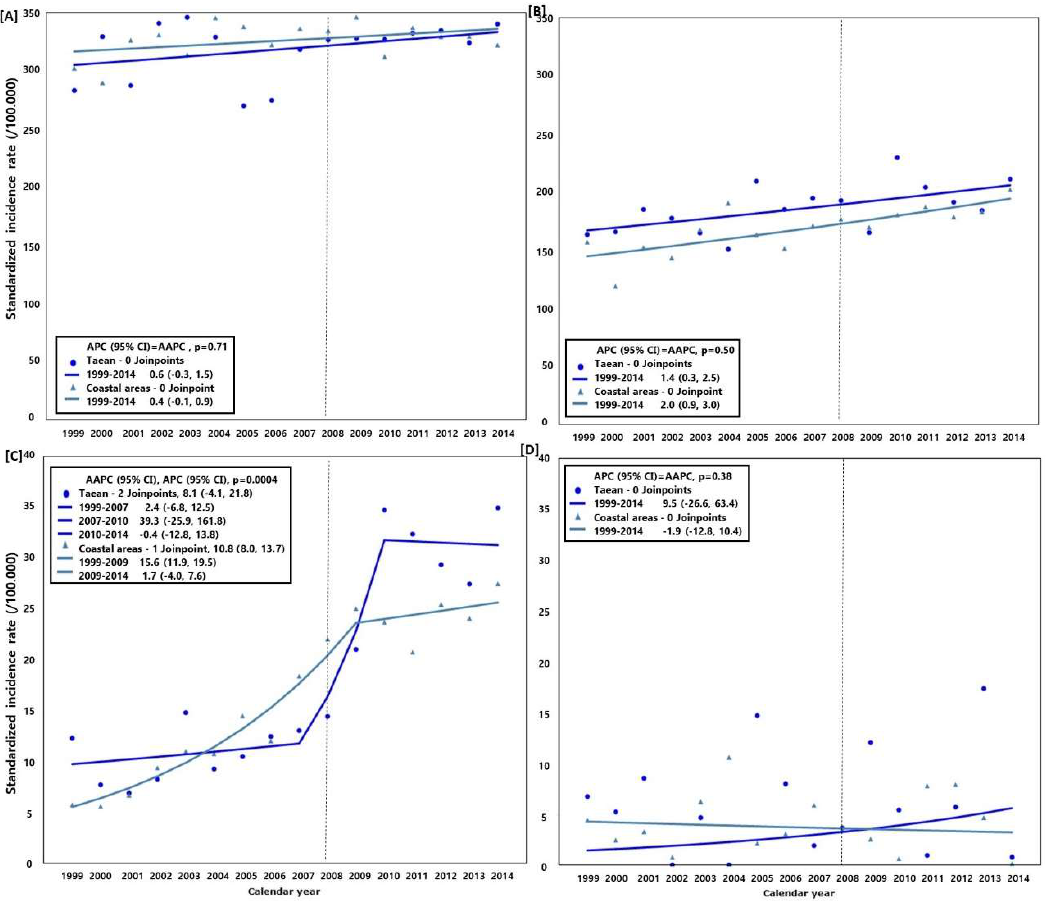
Figure 3. Comparison of the cancer incidence rate and average annual percent change (AAPC) between Taean and the other coastal areas, 1999−2014; Model selection and p -value estimated using the Monte Carlo Permutation method. ( A ) All cancers (C00−C96) excluding thyroid cancer (C73) in Carlo Permutation method. ( A ) All cancers (C00 − C96) excluding thyroid cancer (C73) in men; ( B ) All men; ( B ) All cancers (C00−C96) excluding thyroid cancer (C73) in women; ( C ) Prostate cancer (C61); cancers (C00 − C96) excluding thyroid cancer (C73) in women; ( C ) Prostate cancer (C61); and ( D ) and ( D ) Leukemia (C91−C95) in women. Coastal areas were selected based on their similarities to Leukemia (C91 − C95) in women. Coastal areas were selected based on their similarities to Taean